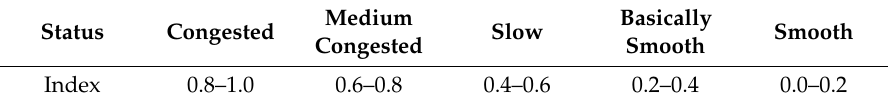
Table 6. Urban Tra ffi c Index in Di ff erent Tra ffi c Conditions. Table 6. Urban Traffic Index in Different Traffic Conditions.